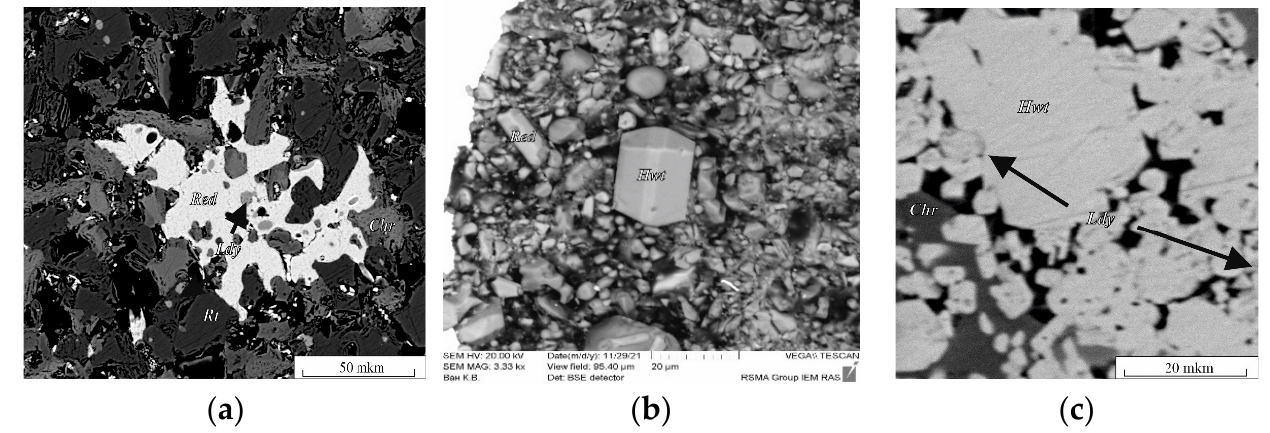
Figure 1. BSE images of run products in the systems: ( a ) chromite–rutile with H 2 O–CO 2 –BaCO 3 fluid; ( b ) synthetic crystals of hawthorneite and redledgeite; ( c ) chromite–ilmenite with H 2 O–CO 2 –BaCO 3 fluid (Table S1). Chr, chromite; Hwt, hawthorneite; Ldy, lindsleyite; Red, redledgeite; Rt, rutile.